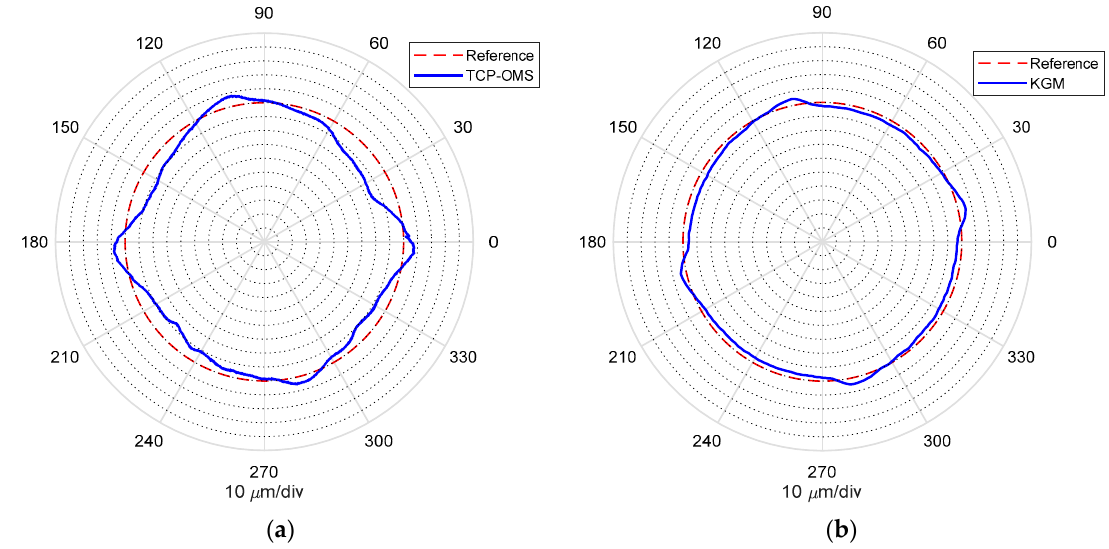
Figure 20. TCP contour errors in F1000 based on circular tests. ( a ) Contour errors of TCP − OMS; ( b ) contour errors of KGM.